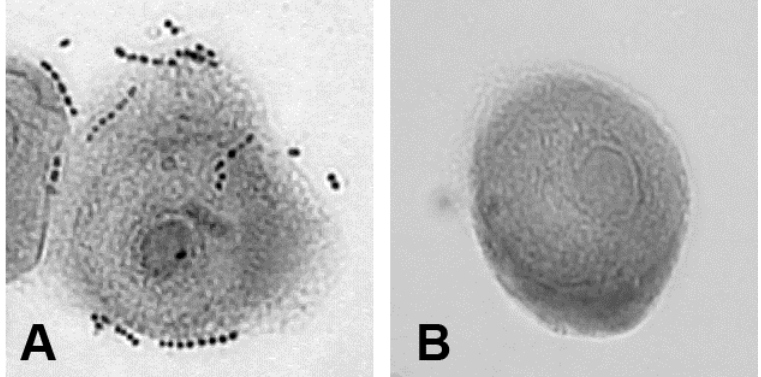
FIGURE 2. Phase contrast images showing adherence of many S. pyogenes (chains of cocci) to ARH-77 cells transfected to express syndecan-1 (A), compared to the lack of S. pyogenes adherence to vector control ARH-77 cell